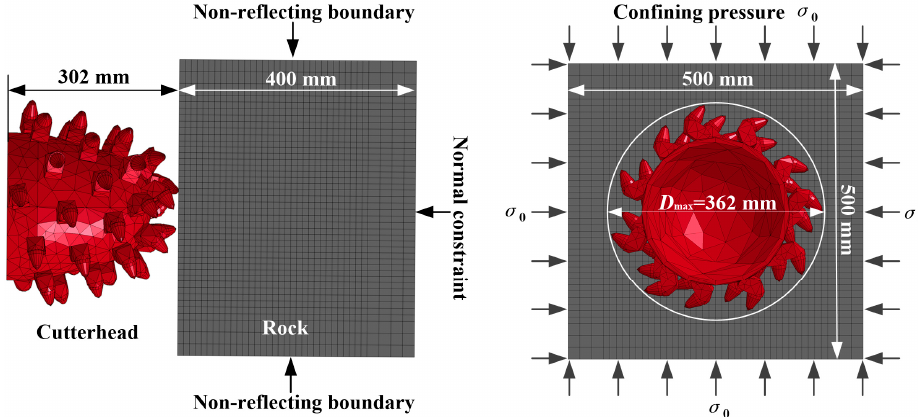
Figure 1. Layouts of the finite element model of rock breaking by the cutterhead.